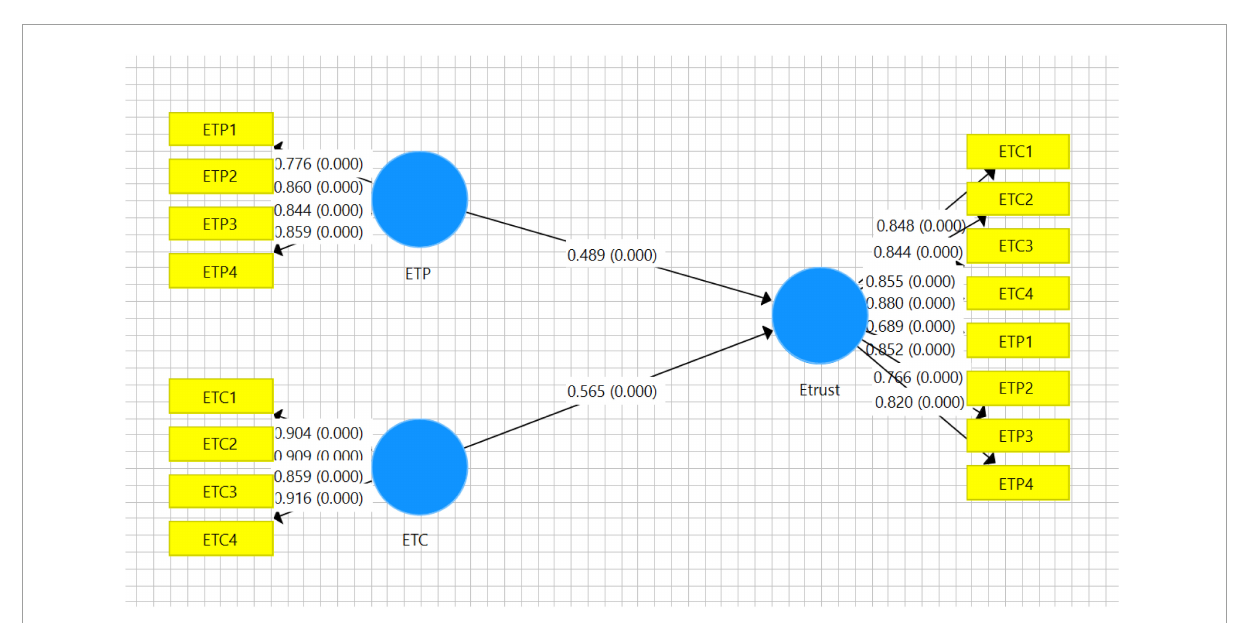
FIGURE3 Analysis of formative electronic trust (eTrust)